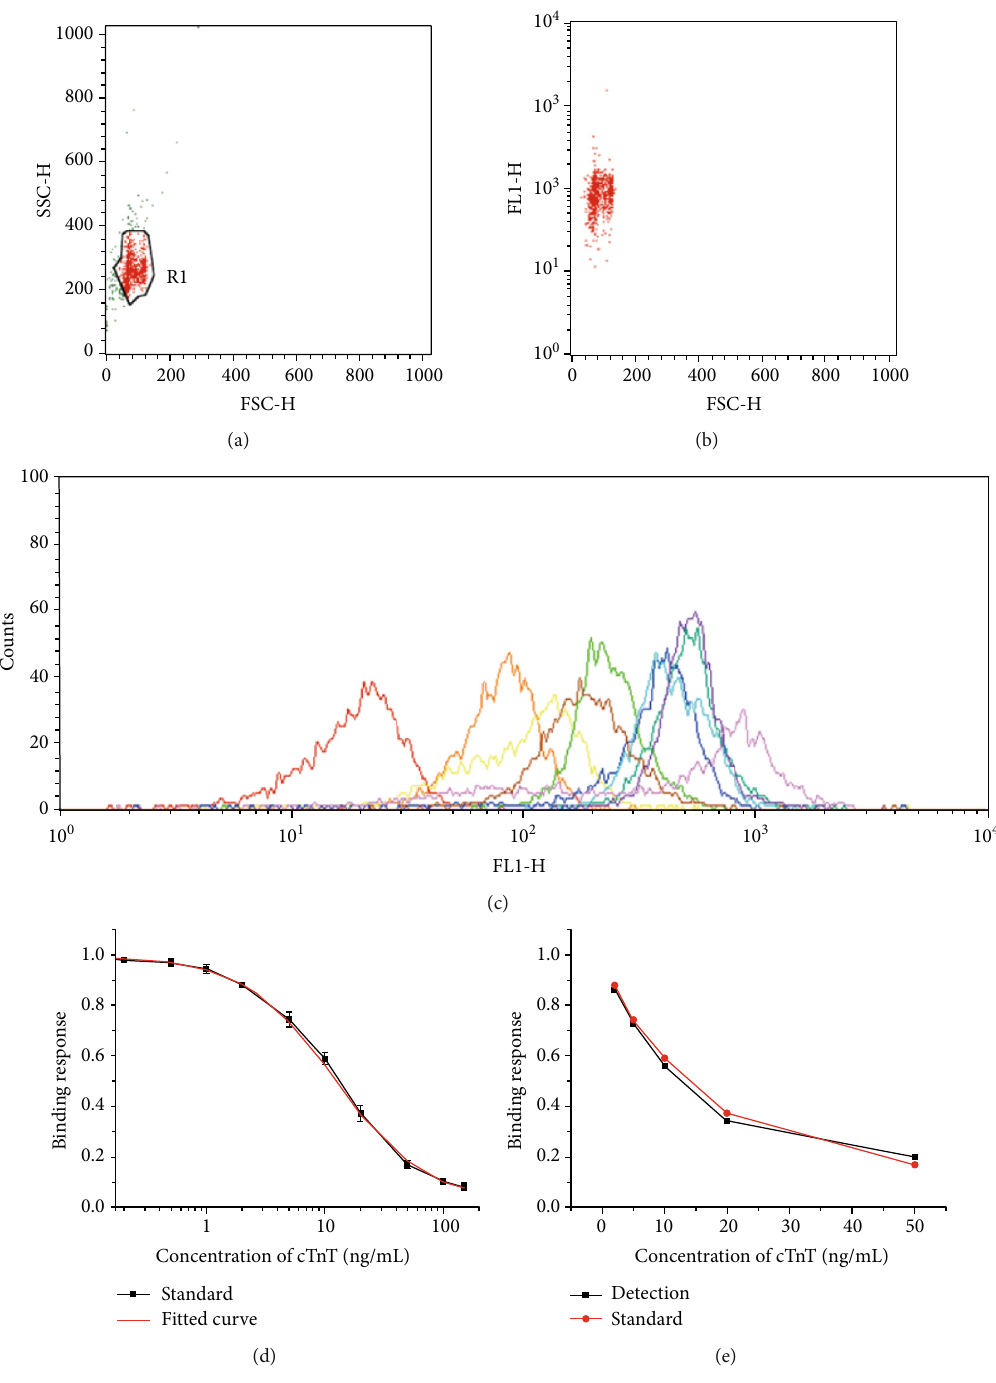
Figure 4: (a) Scatter plots (FSC vs. SSC) of magnetic microspheres – cTnT. (b) Scatter plots (FL1-H vs. FSC-H) of coded magnetic microspheres. (c) Diagram of fl uorescence fi tting curves in the presence of di ff erent concentrations of target cTnT. (d) Binding response of anti-cTnT coupled with magnetic microspheres at di ff erent concentrations of cTnT ranging from 0.1, 0.2, 0.5, 1, 2, 5, 10, 20, 50, and 100 to 150ng/mL. (e) Assay control of detection at di ff erent concentrations of